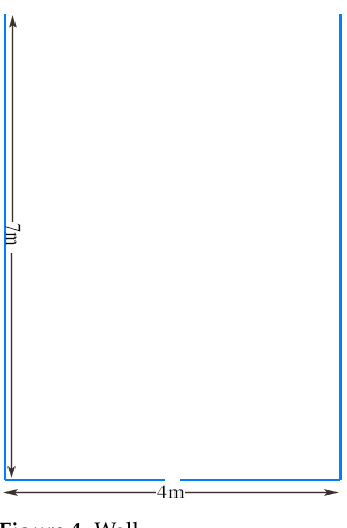
Figure 4. Wall. Table 1. The physical and mechanical parameters of soil particles.